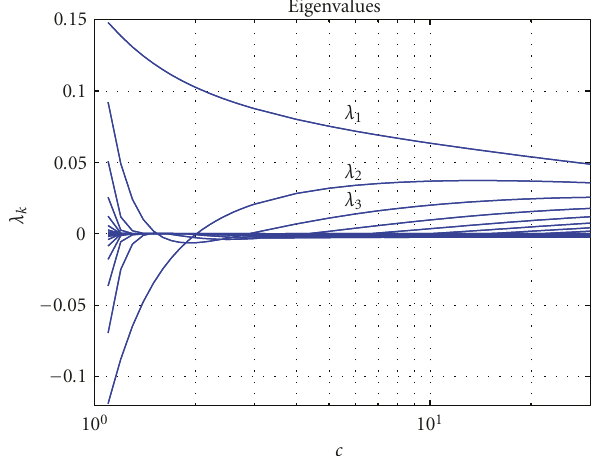
Figure 7: Eigenvalues, dependence on the parameter c . Number of averaged spectrograms